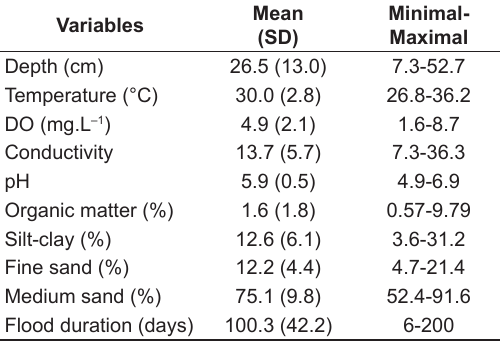
Table 2. Environmental variables measured in 26 plots in February 2007 at the Long-Term Sampling Site (LTSS), Pantanal, Brazil.